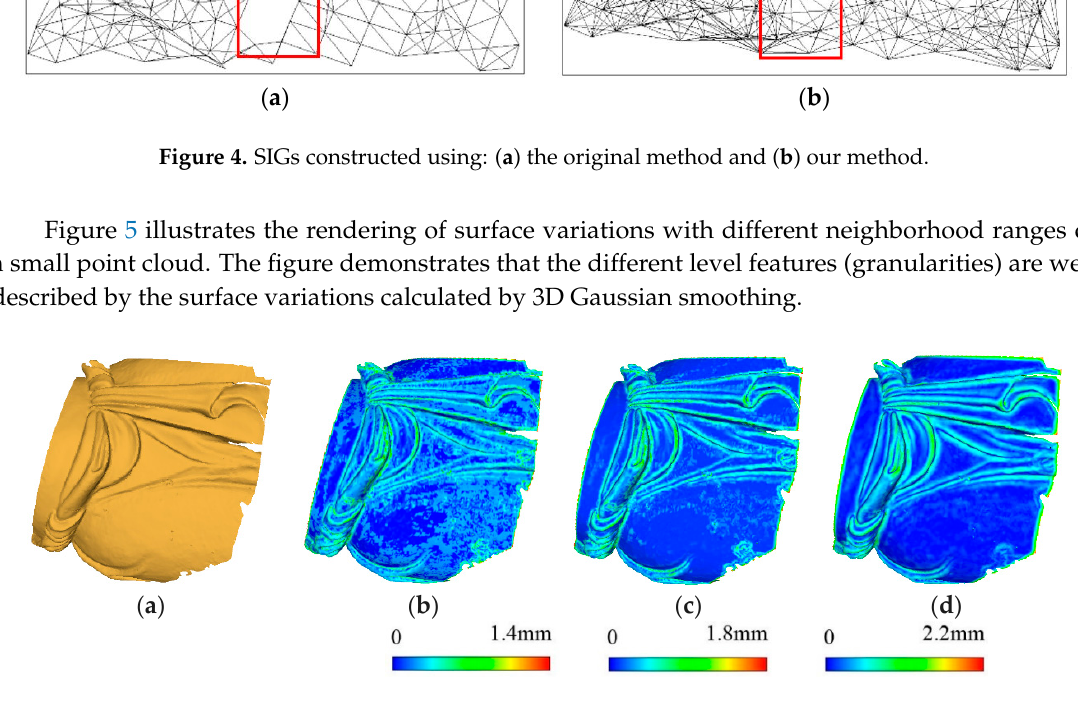
Figure 5. Rendering of surface variations of different levels. ( a ) Original data, ( b ) rendering of surface variations at level δ = 2.0, ( c ) rendering of surface variations at level , and ( d ) rendering of surface variations at level 4.0 =δ .